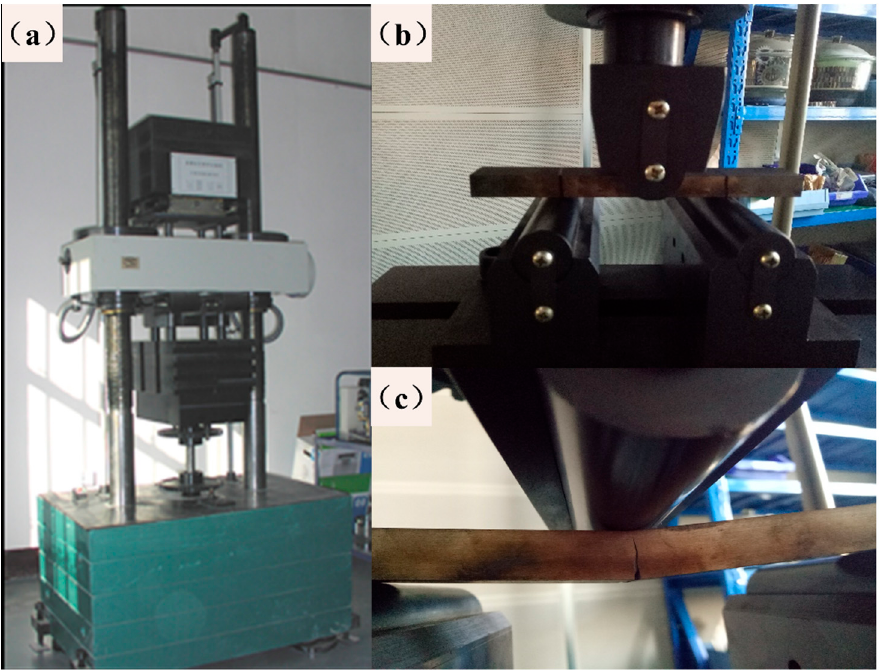
Figure 4. Images of the three-point bending specimen loading: ( a ) testing machine, ( b ) sample before loading, and ( c ) sample after loading.